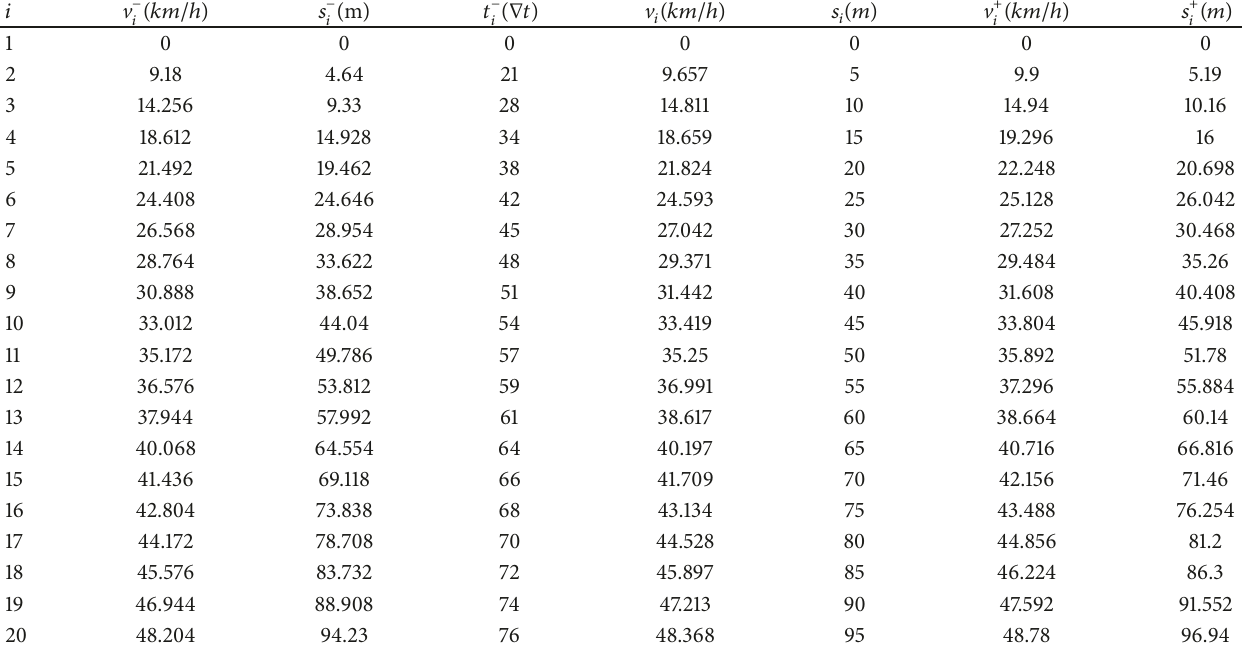
Table 4: Part of the velocity series after being processed.